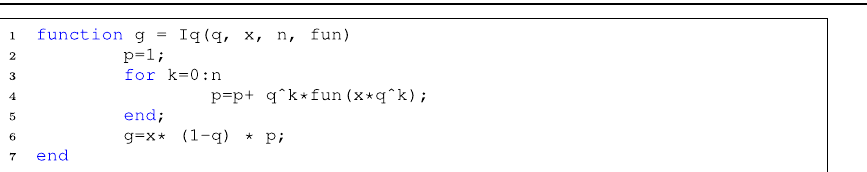
Algorithm 5 The proposed method for calculating